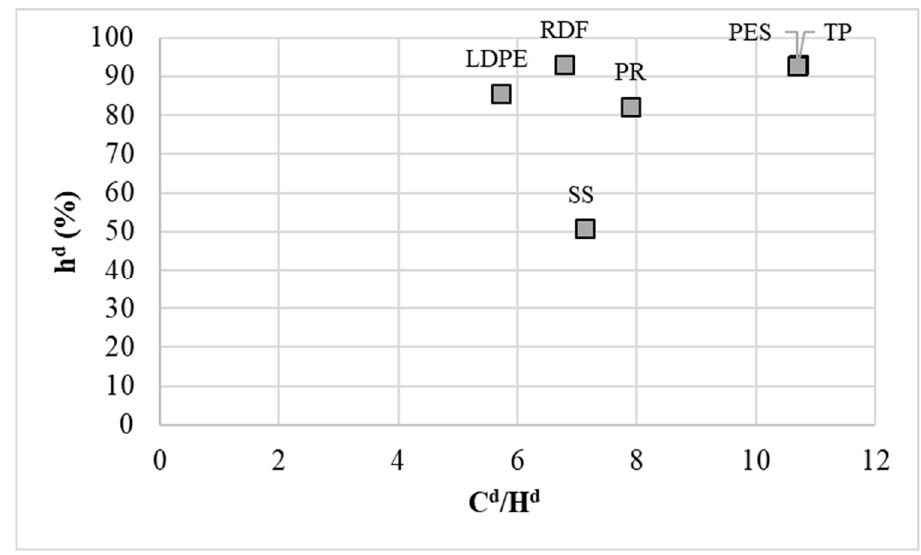
Figure 6. Combustible matter h d (%) and the ratio C d /H d , d means in dry matter.